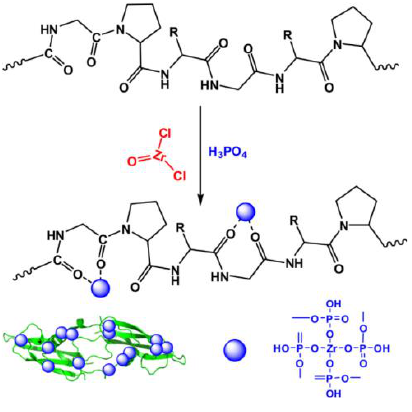
Figure 4. Proposed mechanism for the synthesis of gelatin-Zr(IV) phosphate nanocomposite (GT/ZPNC) ([101], with permission of Elsevier).